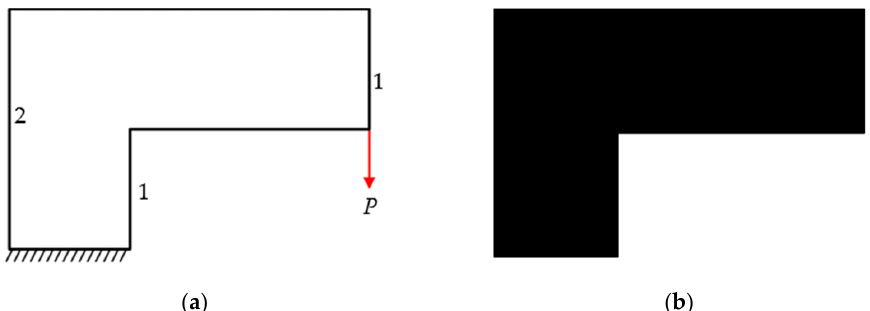
Figure 8. Optimum design problem of C-shaped bracket, ( a ) design domain and boundary conditions; ( b ) initial shape.